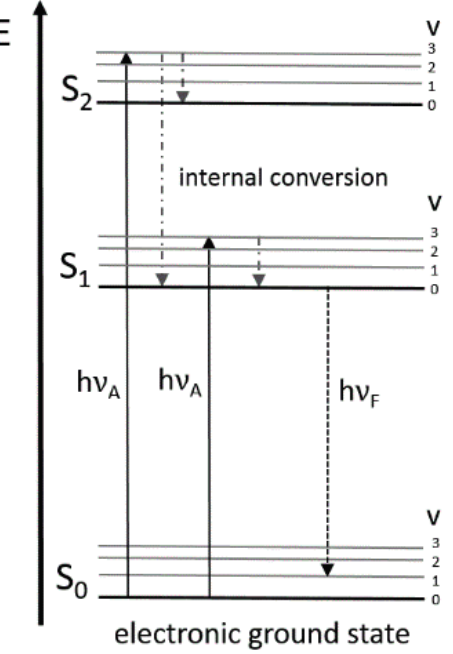
Figure 1. Energy level diagram (Jablonski diagram) for visualization of fluorescence phenomena (see explanation in the